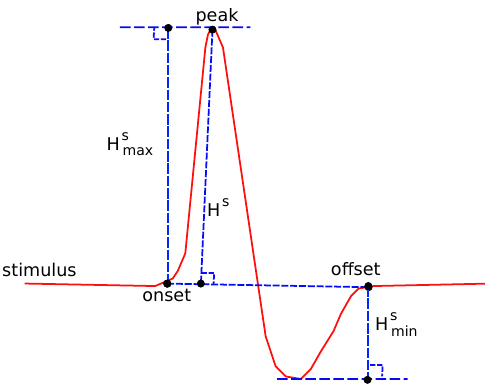
Figure 2. Several features related to definitions about amplitude.